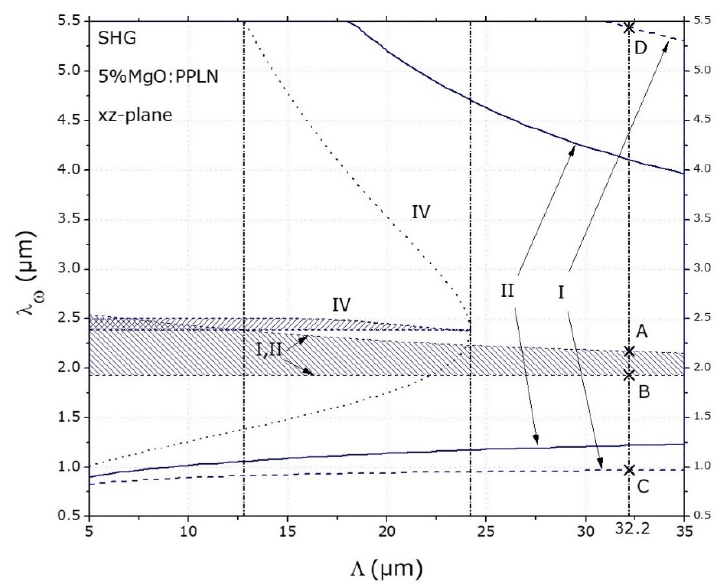
Figure 10. Fundamental wavelength tuning ranges (solid curves) and maximal acceptance domains (hatched zones) of types I, II, and IV AQPM SHG calculated in the xz-plane as a function of the grating periodicity Λ . Points A, B, C, and D refer to the points appearing on the tuning curves of Figure 7a.